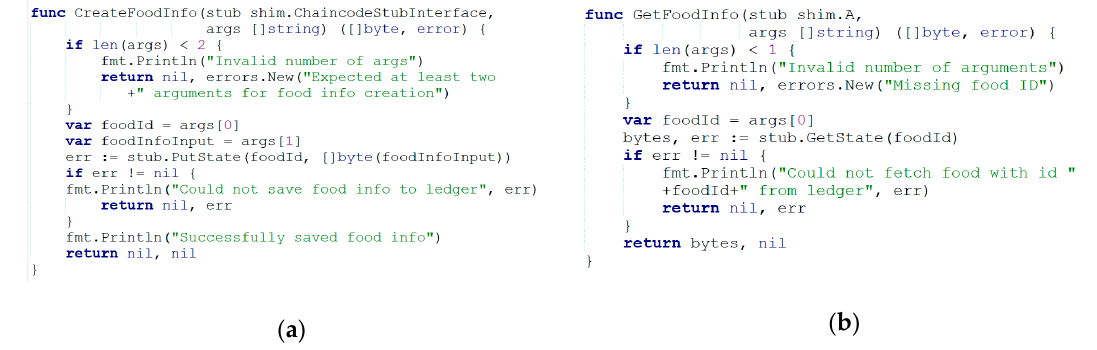
Figure 4. ( a ) Upload the data to the blockchain. ( b ) Retrieve the data from the blockchain.